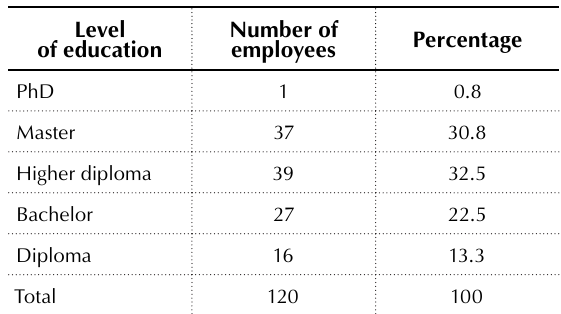
Table 6. T -test alpha value test